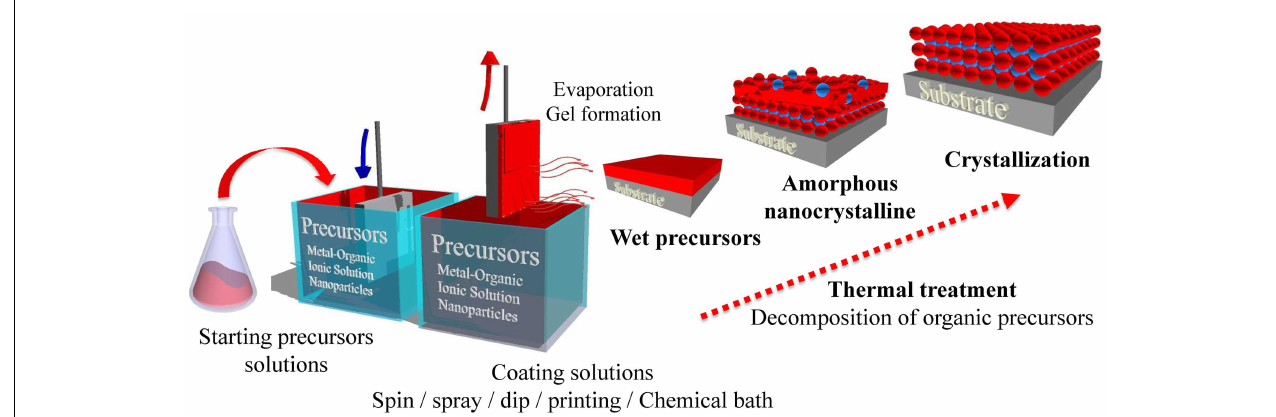
FIGURE 2 | Scheme of the formation of epitaxial thin films of perovskite-based oxides via solution processing routes (dip-coating).